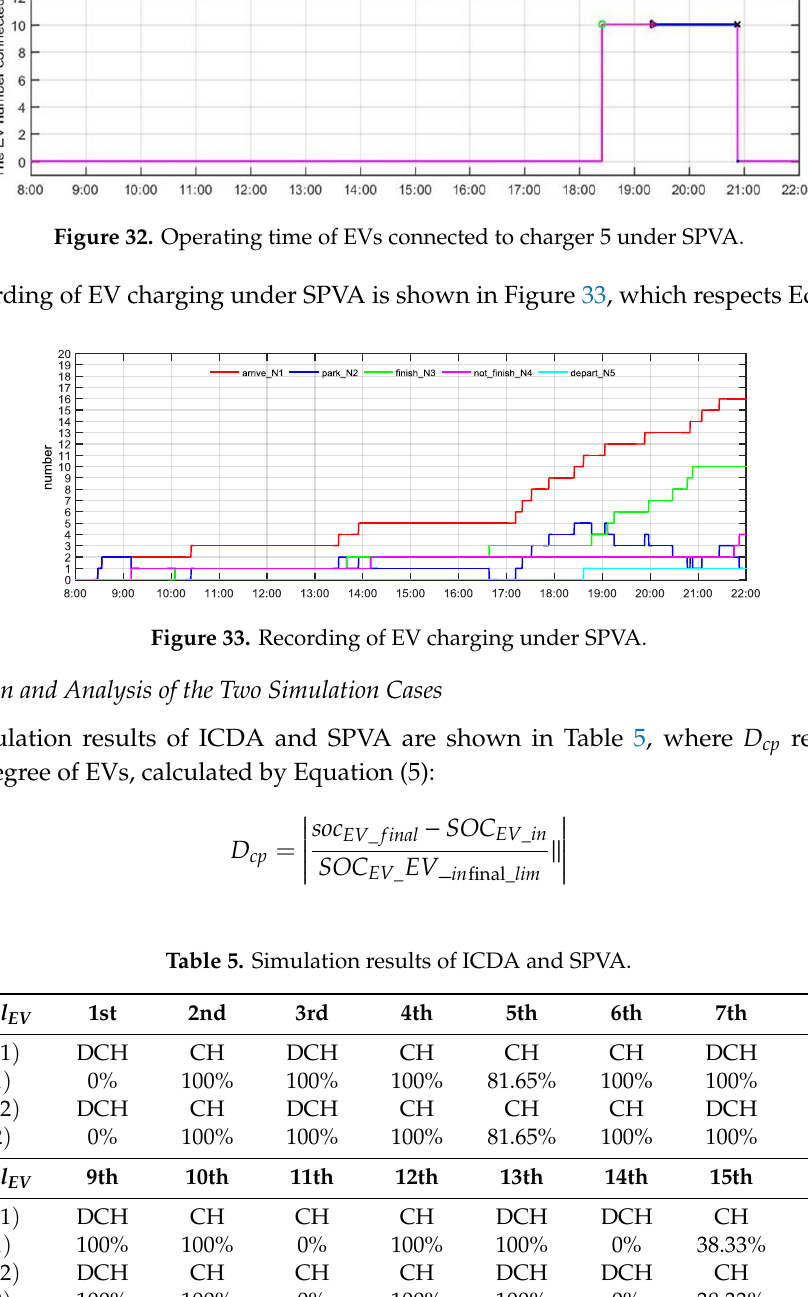
Table 5. Simulation results of ICDA and SPVA.